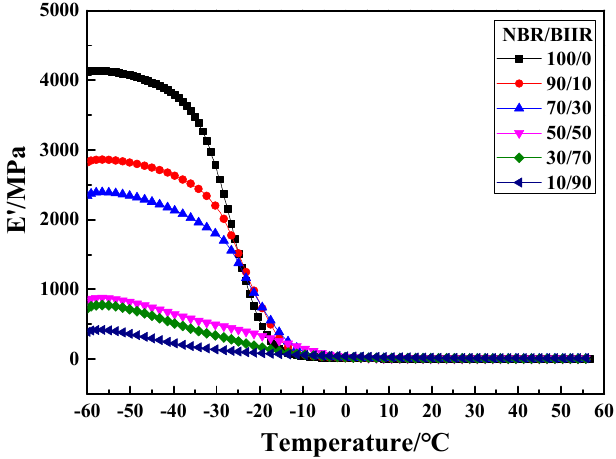
Figure 9 . Storage modulus E ′ versus temperature of NBR/BIIR with various blend ratios. Figure 9. Storage modulus E (cid:48) versus temperature of NBR / BIIR with various blend